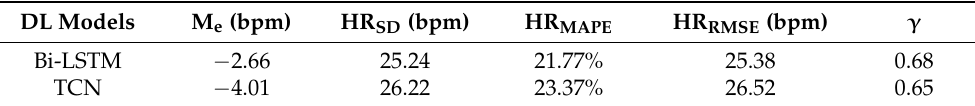
Table 4. Inputting a 0.4 s ECG segment and forecasting following 1.6 s, the iHR estimation perfor- mance comparisons on the A Large Scale 12-lead Electrocardiogram Database at different models (CNN and RNN) are shown. All the ECGs were filtered by the NLM method, and signals of CNN and RNN were set at a sampling rate of 640 Hz and 128